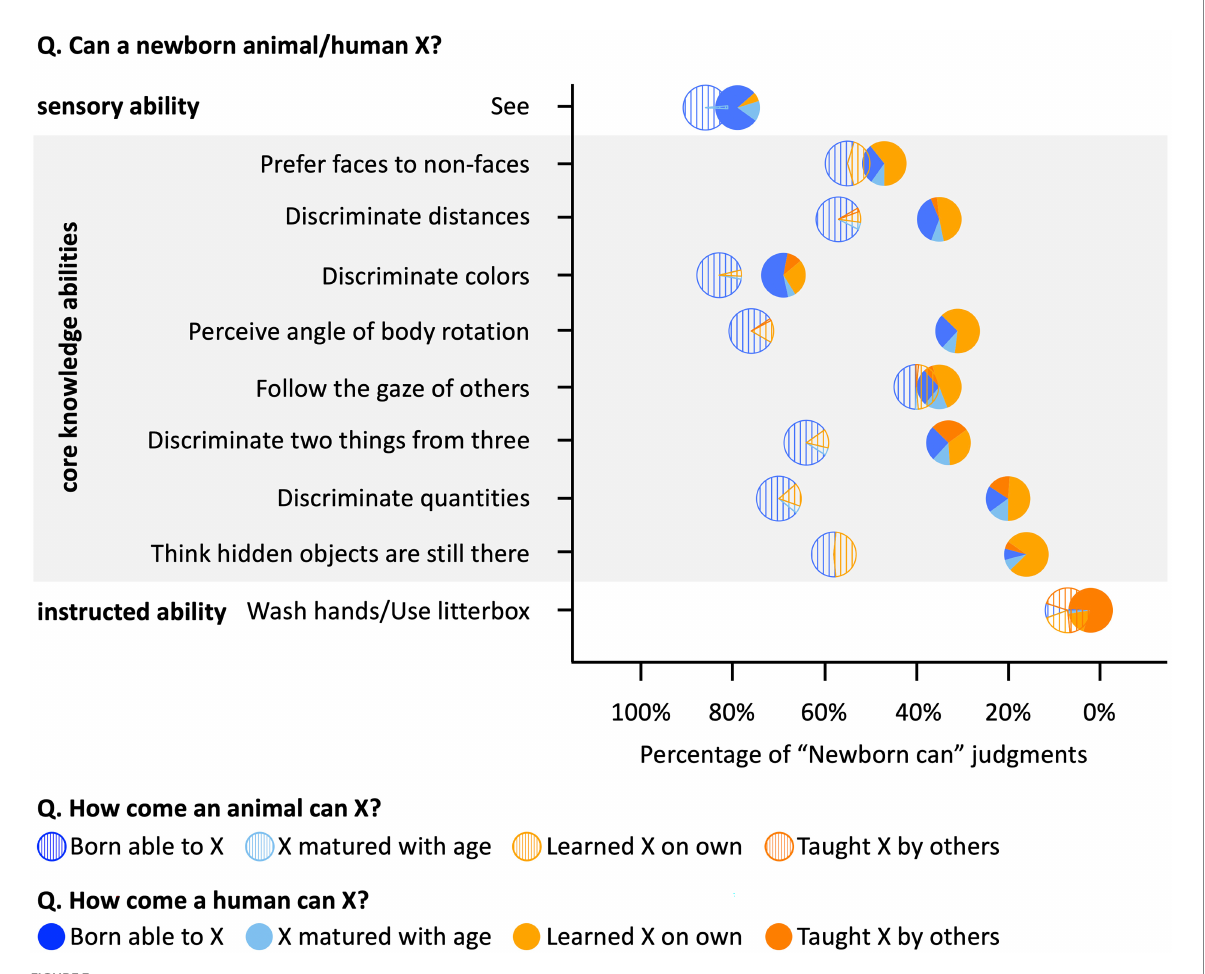
FIGURE 3 Methods and results for Study 1C. Circles’ left–right positions represent percentage that participants judged the corresponding abilities exist in newborns. Circles’ colors represent the distribution of free